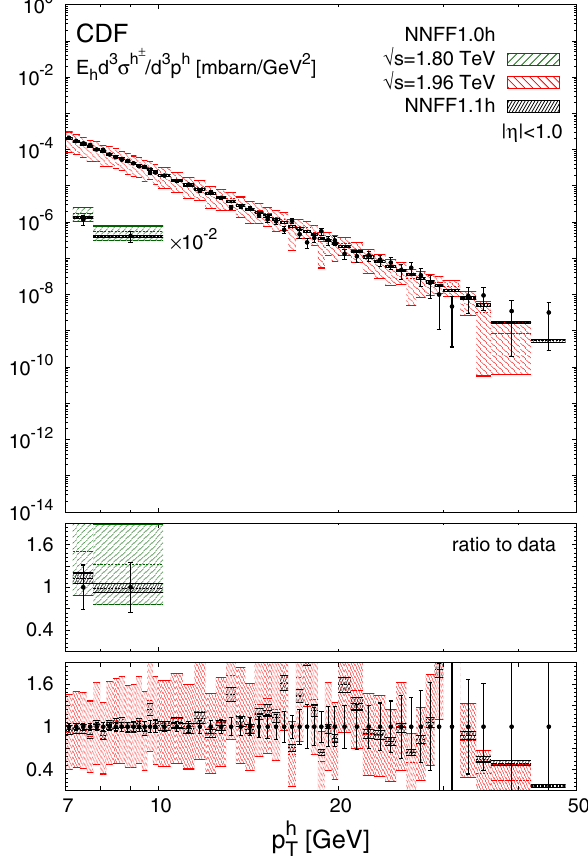
Fig. 3 The differential cross section, Eq. (2), for the inclusive charged hadron spectra measured by CDF in proton-antiproton collisions at dif- ferent centre-of-mass energies over the rapidity range | η | < 1. The data is compared to the NLO predictions obtained with NNFF1.0h and NNFF1.1h. The corresponding theory/data ratio is shown in the lower panels. The bands include the one- σ FF uncertainty only. We show the sum in quadrature of the uncorrelated uncertainties on the data points, while correlated systematic errors are taken into account via shifts of the theoretical predictions (see